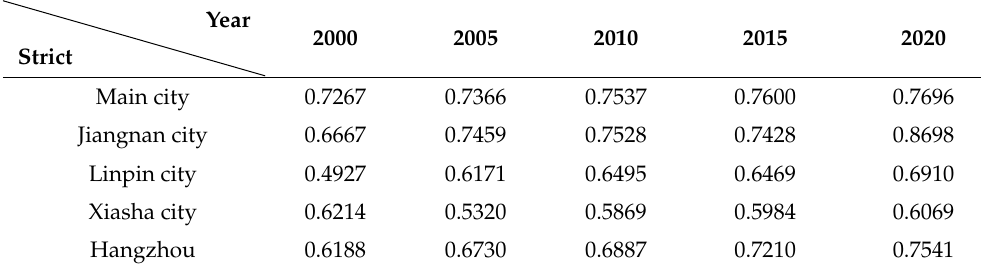
Table 5. Land-use structural balance of Hangzhou in different